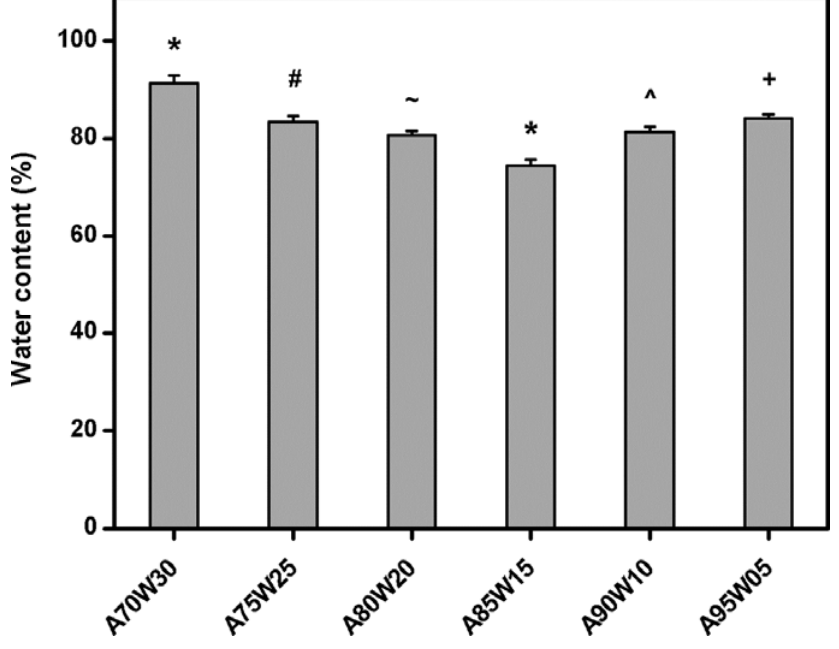
Figure 1. Equilibrium water content of 1-ethyl-3-(3-dimethyl aminopropyl) carbodiimide (EDC) cross-linked hyaluronic acid (HA) membranes as a function of solvent